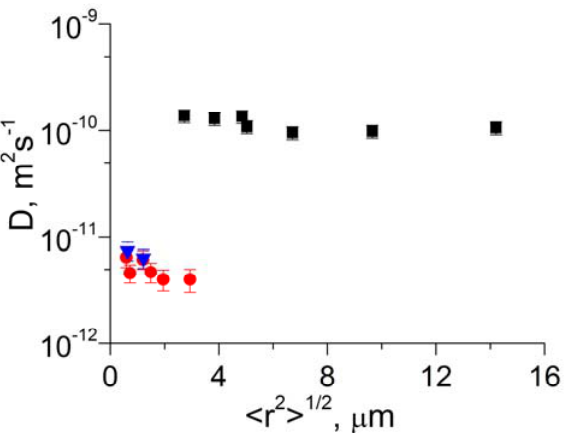
Figure 3. Dependences of the methane self-diffusion coefficient on the root MSD at T = 297 K for 6FDA/BPDA ( ■ ), Matrimid Sample 1 ( ● ), and Matrimid Sample 2 ( ▼ ). The data was obtained using Equation (1) with n = 1 and Equation